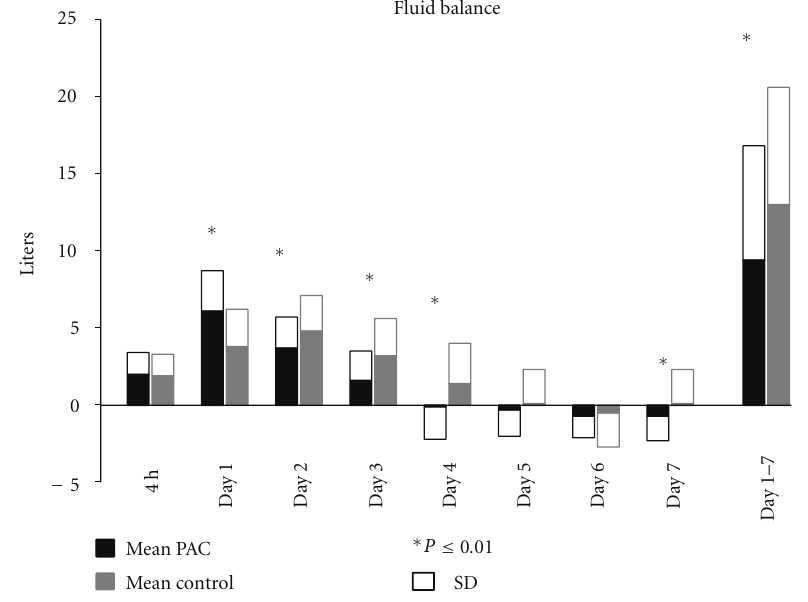
Figure 2: Fluid balances in the first week. Table 3: Secondary outcome variables: morbidity and